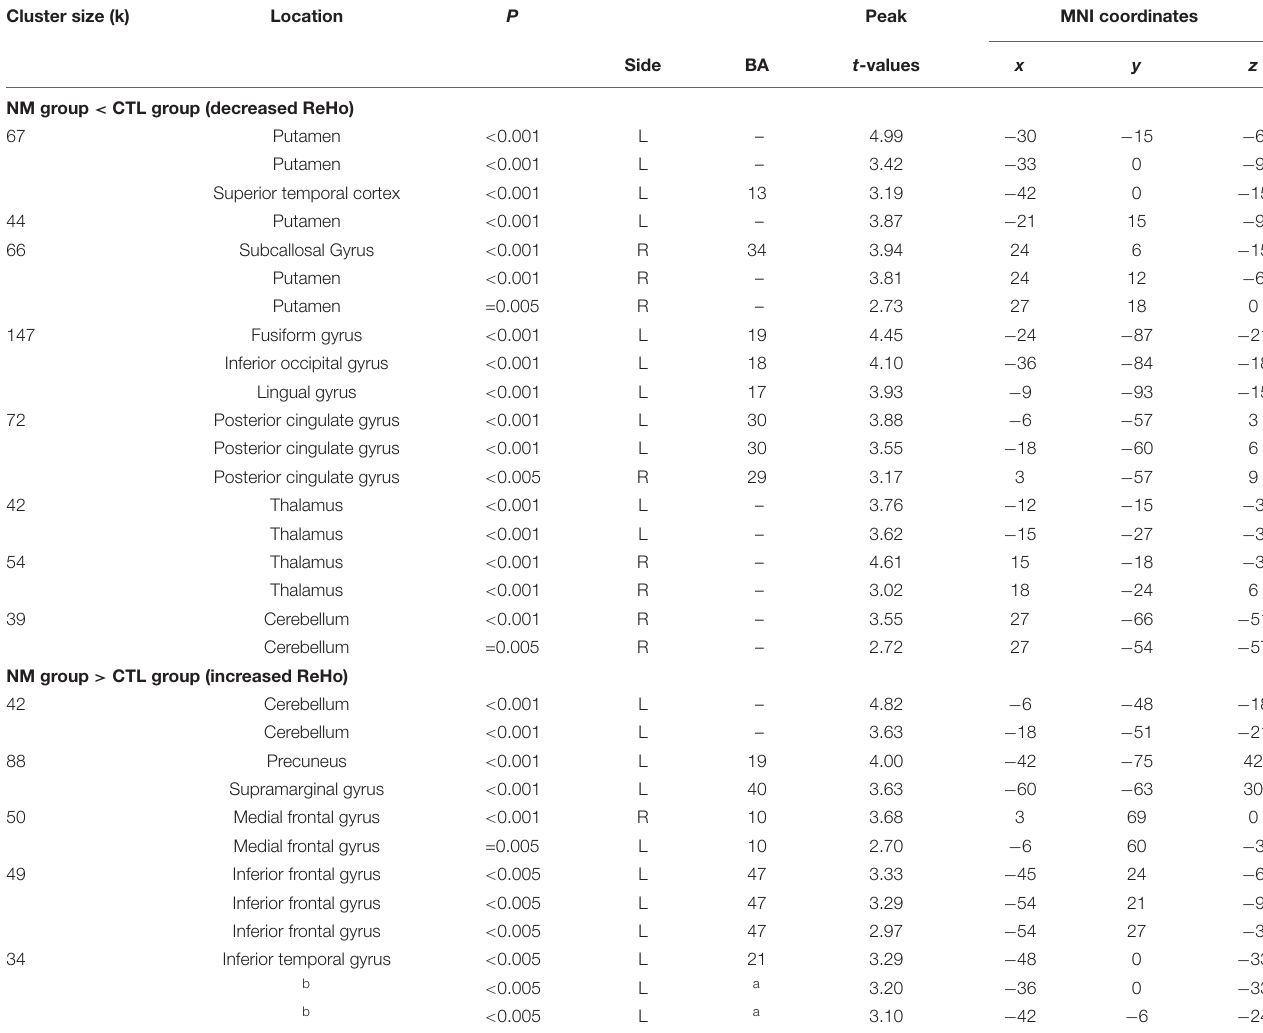
TABLE 2 | Localization of group differences in ReHo